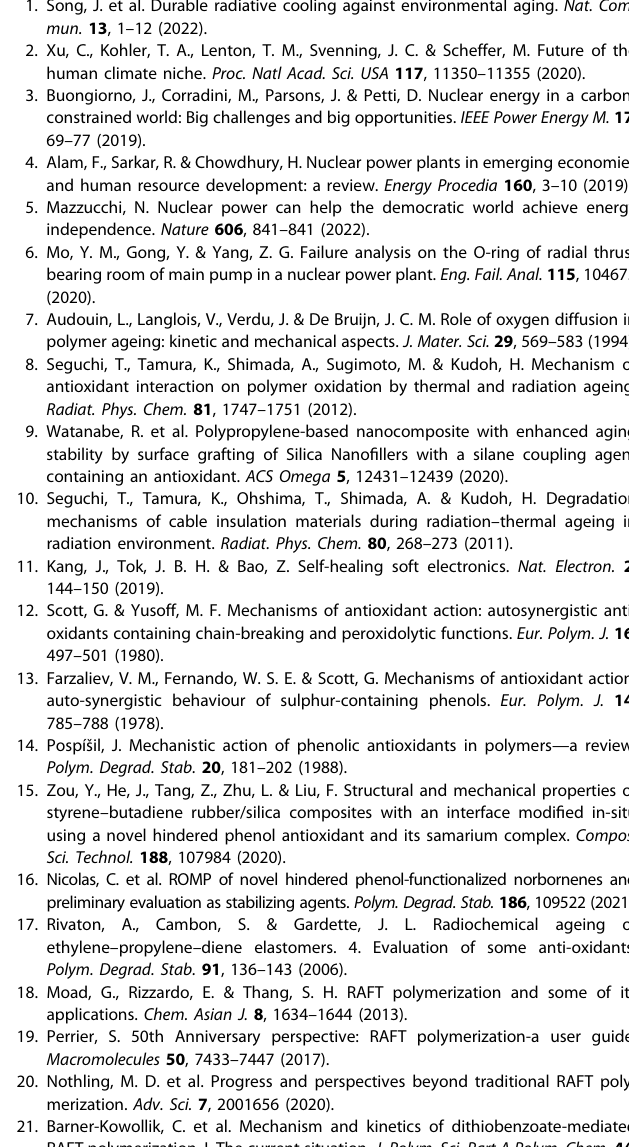
The stress relaxation dynamics of the unirradiated and irradiated EPDM samples were measured under a strain of 3% and at a temperature of 180 °C using a rheometer (DHR-1, TA Instruments, USA) and 8-mm parallel plates. The samples were